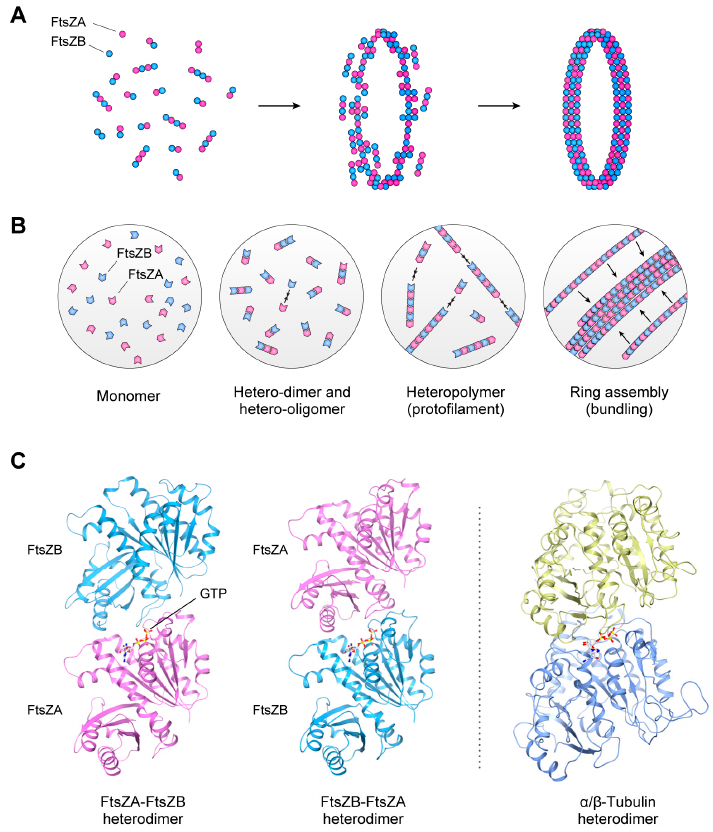
Figure 2. Assembly of the FtsZ ring. ( A , B ) FtsZ molecules assemble into hetero-oligomers, then these FtsZ protofilaments bundle and assemble into a ring structure in the stroma region. ( C ) The two types of FtsZs can assemble into heteropolymer structures via FtsZA-FtsZB and FtsZB-FtsZA hetero-interactions. The protein structure of the tubulin heterodimer (PDB: 1TUB) is also shown on the right. The protein structures of A. thaliana FtsZ2 (shown as FtsZA in the Figure) and FtsZ1 (FtsZB in the Figure) were obtained using homology modeling in the Modeller program [35], and structural data for each protein molecule were visualized using CueMol: Molecular Visualization Framework software (http://www.cuemol.org/). Reproduced and modified from Yoshida et al. (2016) [21].